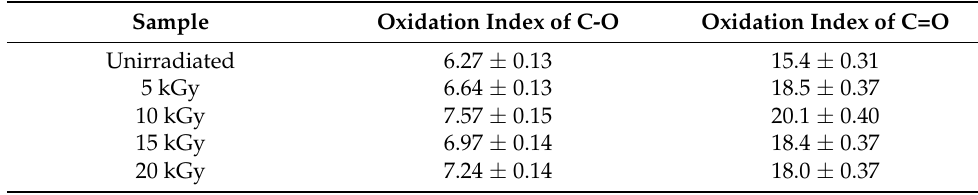
Table 1. The OIs of the C-O bond, using the peak at approximately 1100 cm − 1 , and the C=O bond, using the peak at approximately 1750 cm − 1 . Calculated using the CH 3 peak at approximately 1450 cm − 1 as a reference